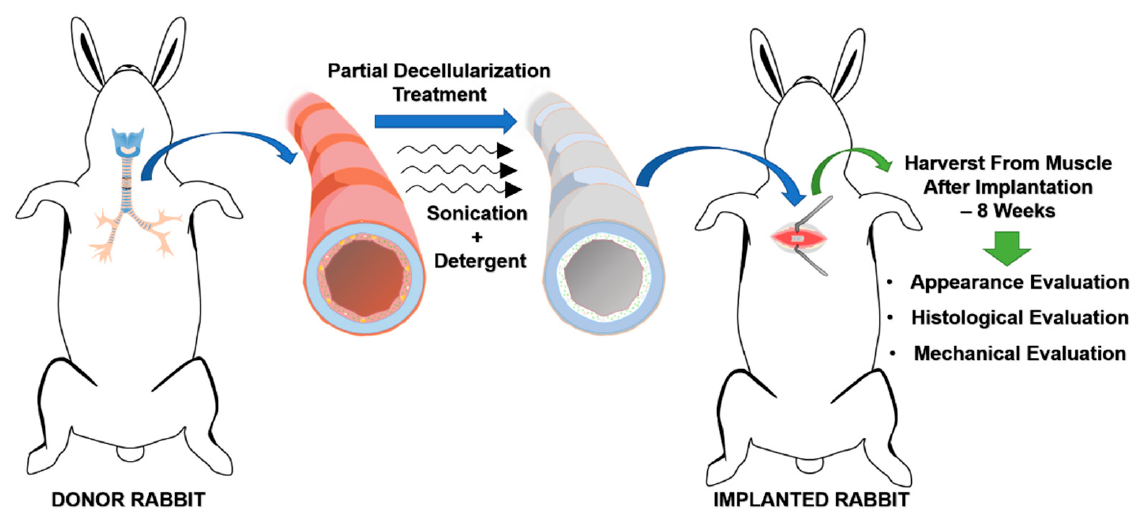
Figure 2. Illustration of heterotopic implantation of the partially decellularized graft into the chest muscle of rabbits.